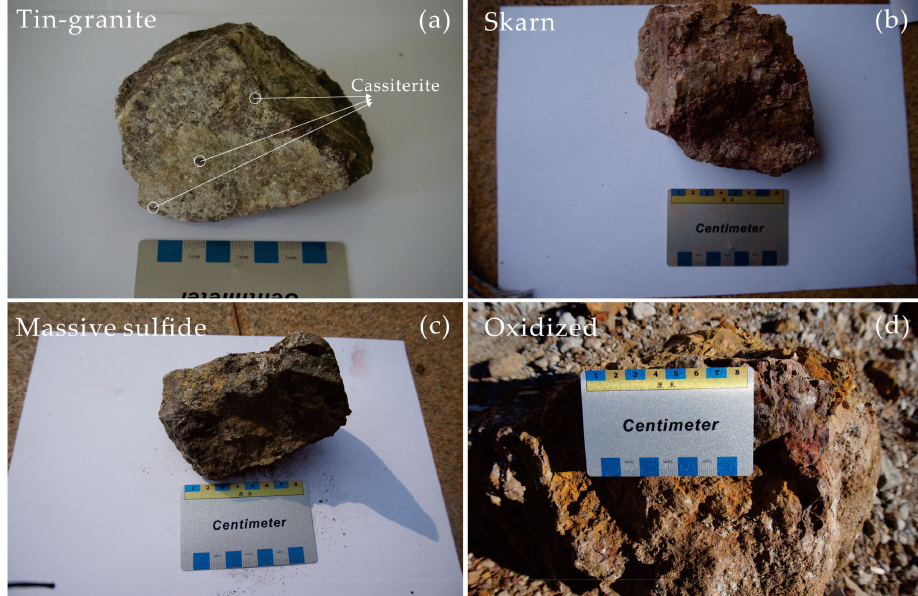
Figure 3. Representative photographs of tin ores from the Gejiu tin polymetallic deposit. ( a ) Tin- granite ore, also called cassiterite-bearing granite, which is only well developed in the interior of certain granite cupolas; ( b ) skarn ore is widely distributed in the contact zone of granite and carbonate, and contains garnet, pyroxene, epidote, and fluorite; ( c ) massive sulfide ore contains sulfide minerals; ( d ) red-brown oxidized ore is hosted in carbonate layers distal to intrusion and reveals a colloidal or honeycomb